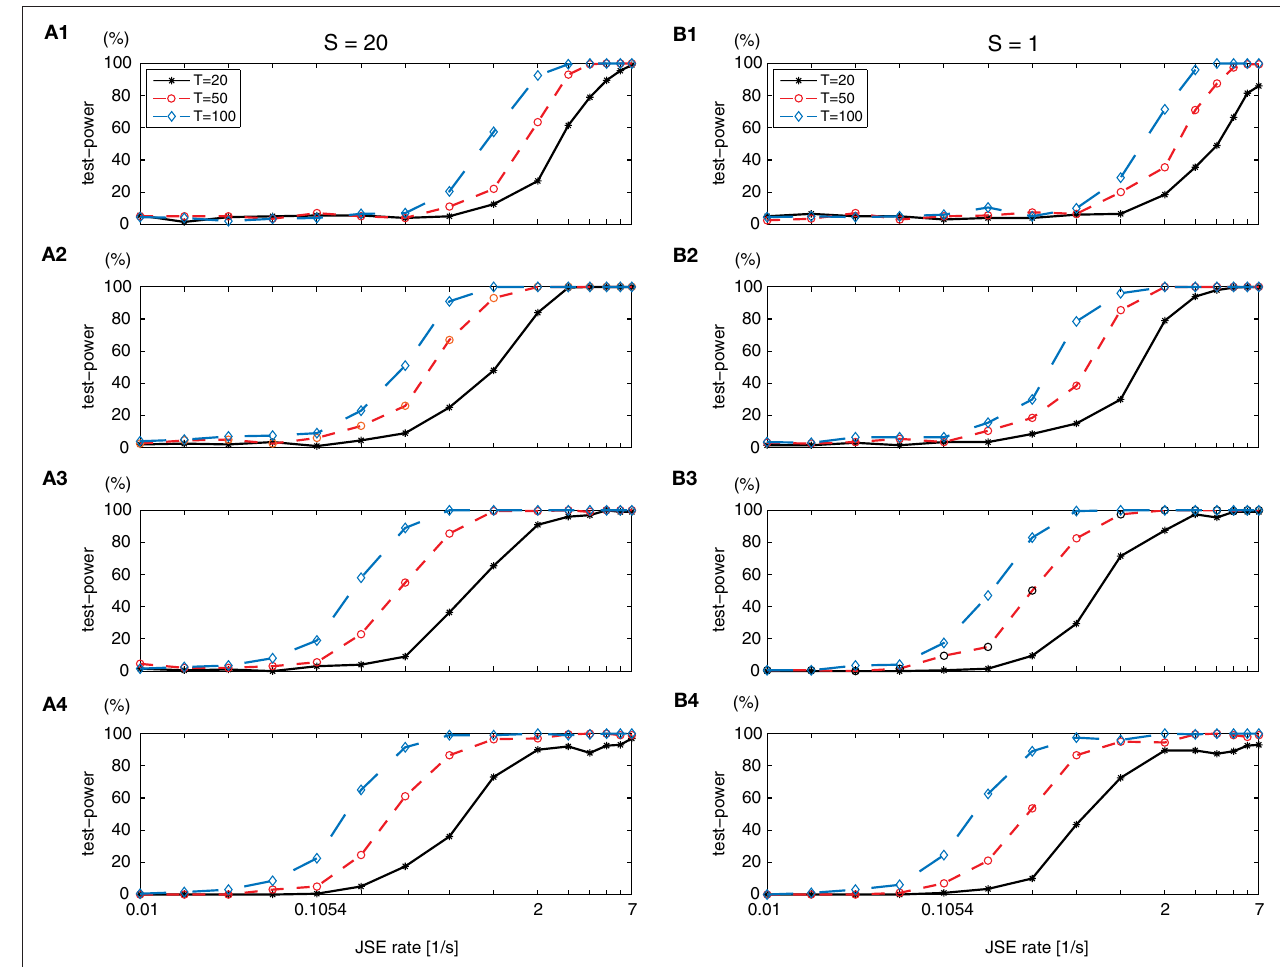
on the complexities of the analyzed JS-patterns with complexities from 2 to 5. (A1–A4) variations in the number of trials T with the number of surrogates S = 20, and (B1–B4) variations in the number of trials T with the number of surrogates S = 1, from a standard parameter set ( T = 50 trials, background spike rate of r = 15 spikes/s, and h